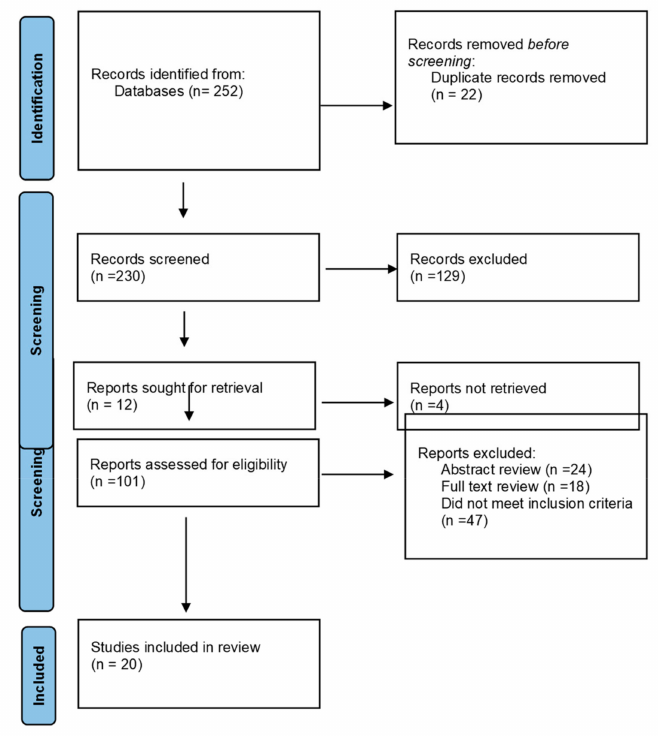
Figure 1. PRISMA flow diagram of search